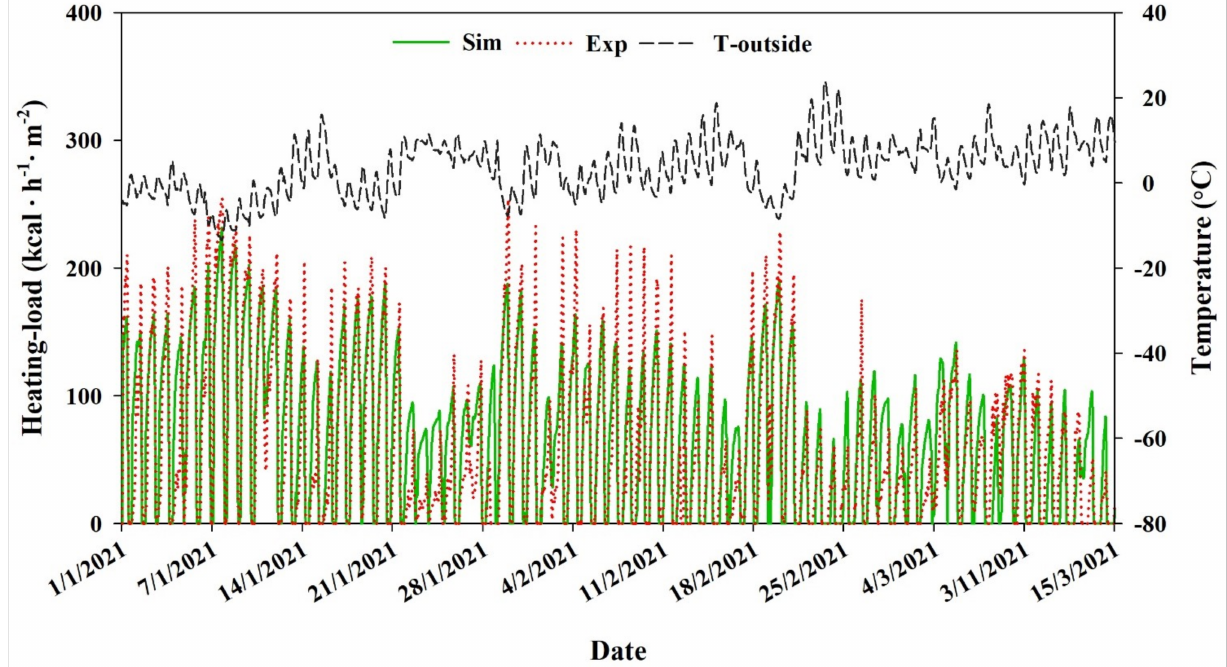
Figure 11. Experimental vs. simulated heating supply from water storage tank to greenhouse. Table 7. TRNSYS estimated maximum heating load of the